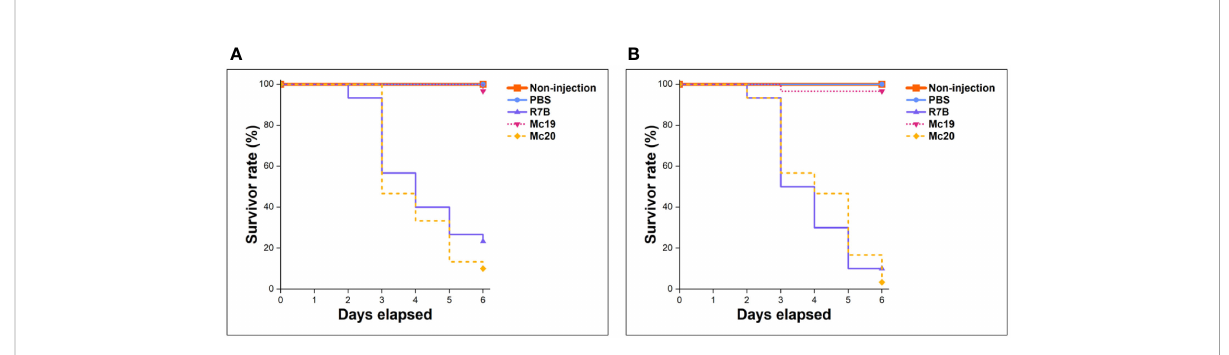
FIGURE 7 Results of virulence assays of myosin II mutants in the Galleria mellonella invertebrate model. Injections contain 5,000 vegetative spores or yeast cells per dose (A) , and 10,000 spores/yeast cells per dose (B)